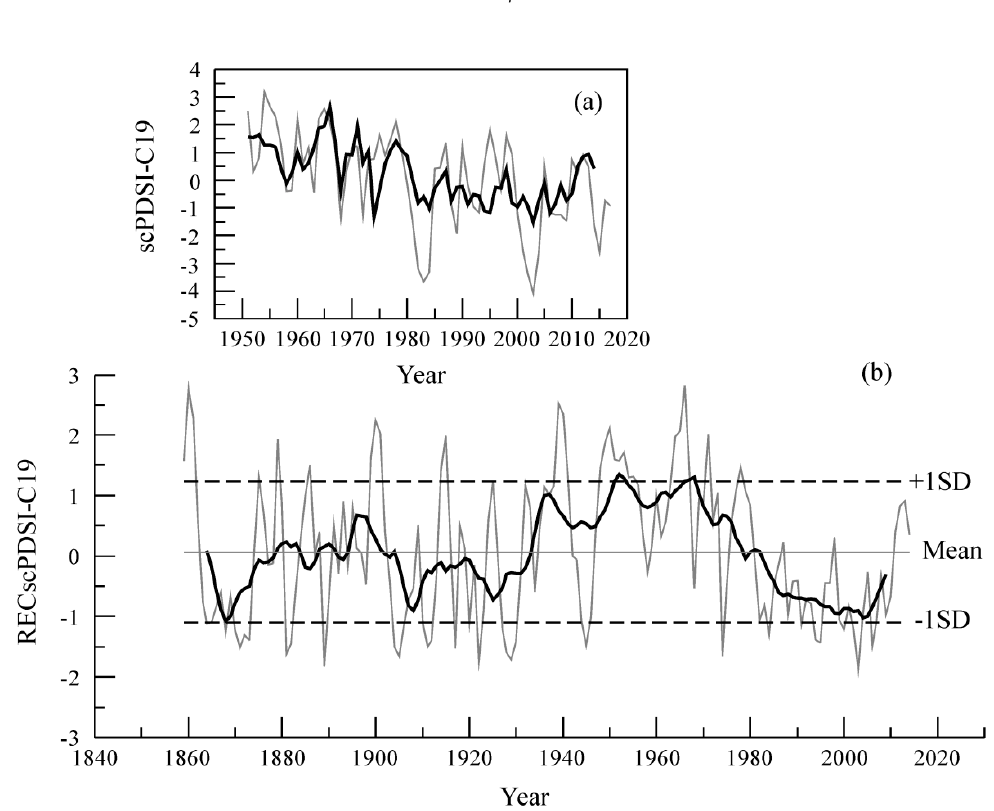
Figure 4. ( a ) Comparison of reconstructed (bold line) and observed (thin line) January–September mean self-calibrating Palmer Drought Severity Index (scPDSI) during the period of 1951–2014 and ( b ) variations in the drought reconstruction during the whole reliable period of 1859–2014 for western Liaoning (the bold line indicates the 11-year moving data and the horizontal lines indicate the mean value along with the extremely high and low values at ± one standard deviation). Table 4. Extreme events of reconstructed January–September mean scPDSI for western Liaoning during the period 1859–2014 .